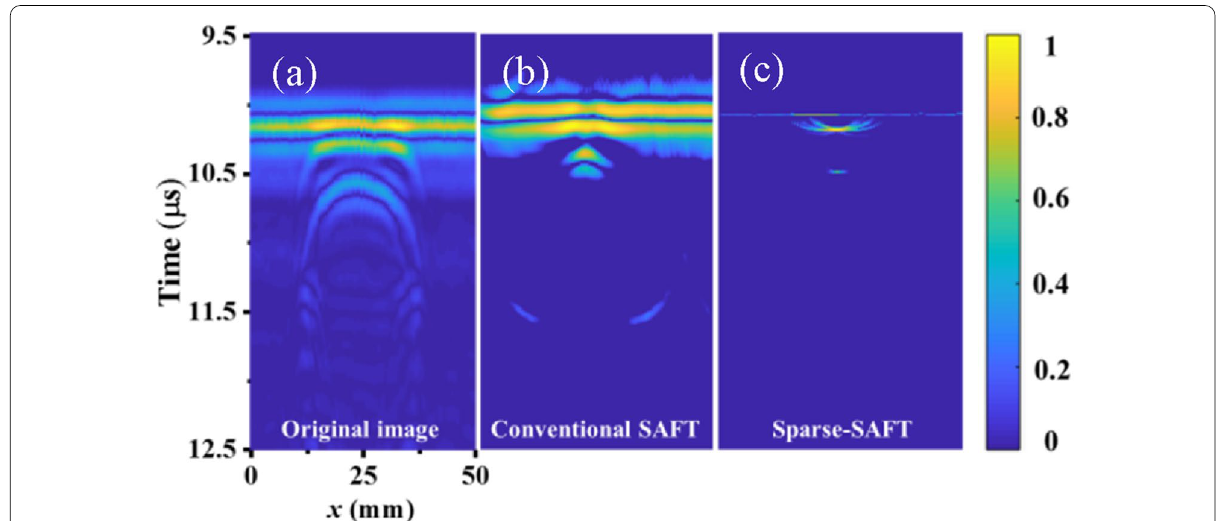
Figure 7 Original image and reconstructed images by experiments: ( a ) original B-scan image, ( b ) reconstructed image by conventional SAFT, ( c ) reconstructed image by